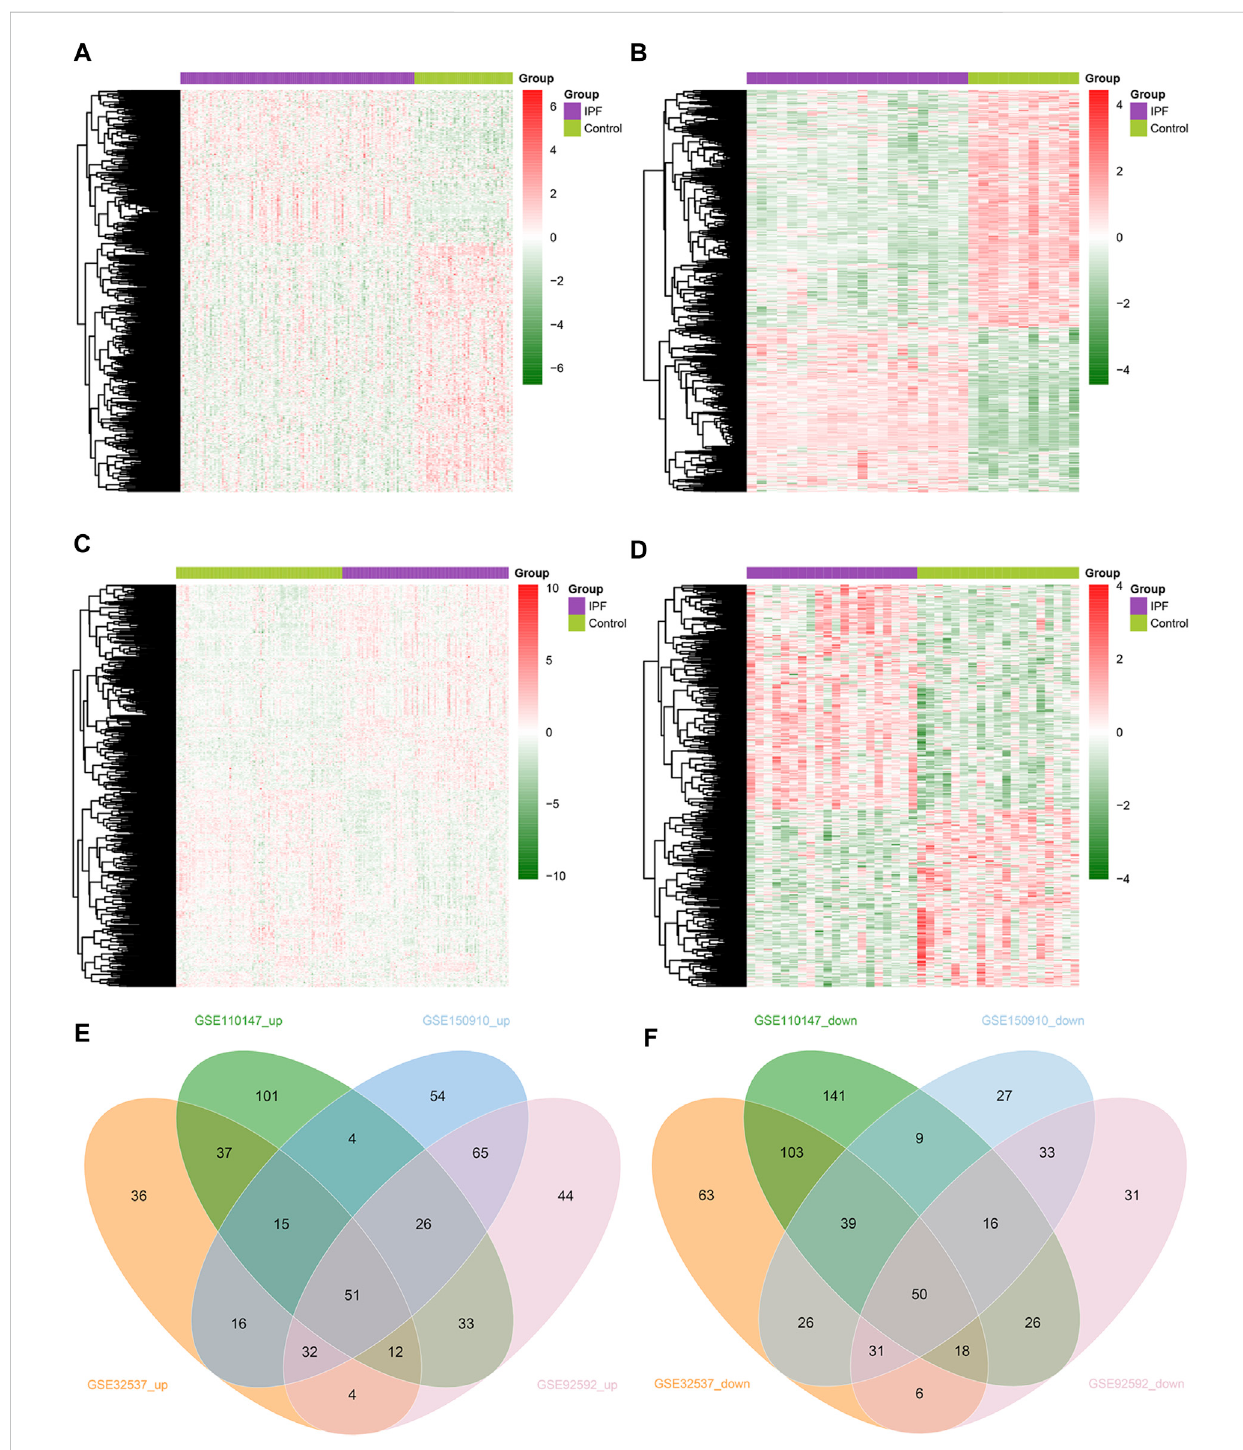
FIGURE 2 Identi fi cationofDEMRGsinIPF. (A) HeatmapofDEMRGsinGSE32537(203upregulatedand336downregulatedDEMRGs). (B) HeatmapofDEMRGs in GSE110147 (279 upregulated and 402 downregulated DEMRGs). (C) Heatmap of DEMRGs in GSE150910 (263 upregulated and 231 downregulated DEMRGs). (D) Heatmap of DEMRGs in GSE92592 (267 upregulated and 211 downregulated DEMRGs). (E) The Venn diagram identi fi ed fi fty-one commonly upregulated DEMRGs. (F) The Venn diagram identi fi ed fi fty commonly downregulated